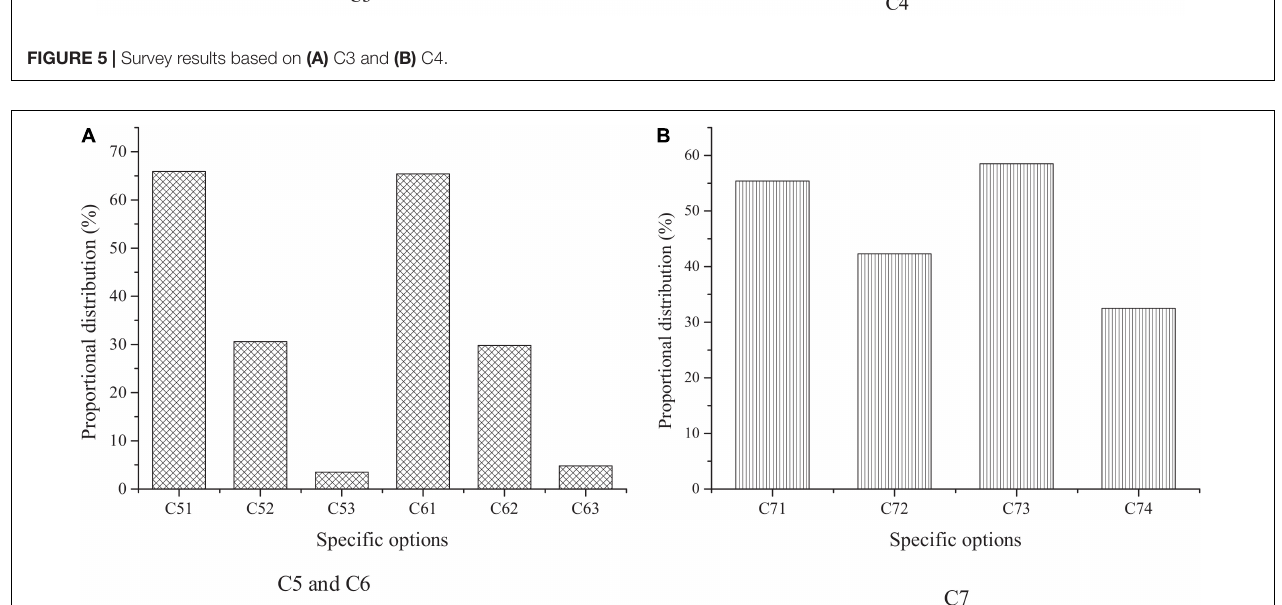
FIGURE 6 | Survey results based on (A) C5 and C6 and (B)